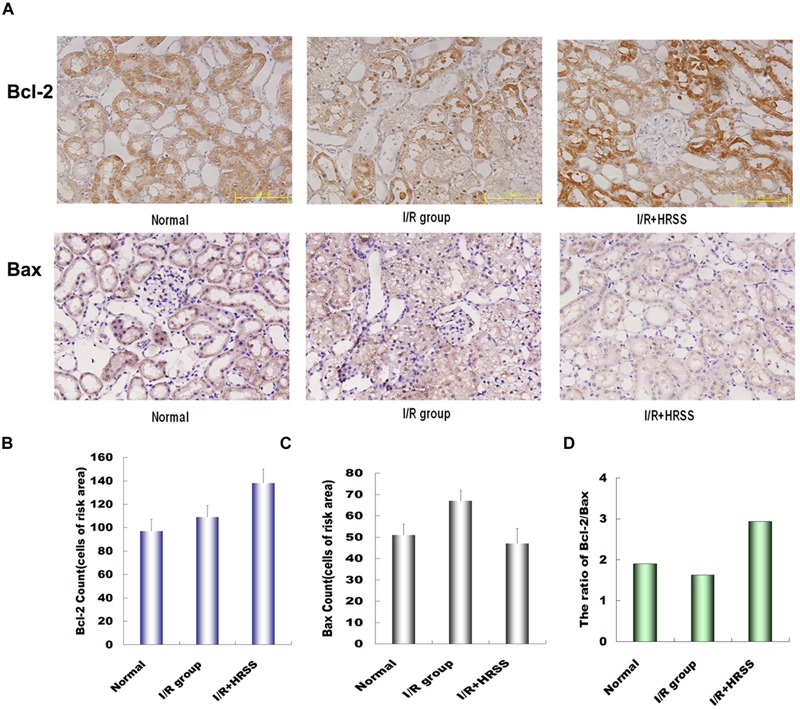
(A) Hydrogen modulated Bcl-2 and Bax expression in renal tissue after I/R injury. (B) Bcl-2 expression was upregulated, while (C) Bax expression was downregulated in renal tissue (P > 0.05). Although the change in Bax expression was not significant, (D) Bcl-2/Bax ratio was significantly altered (P < 0.05).